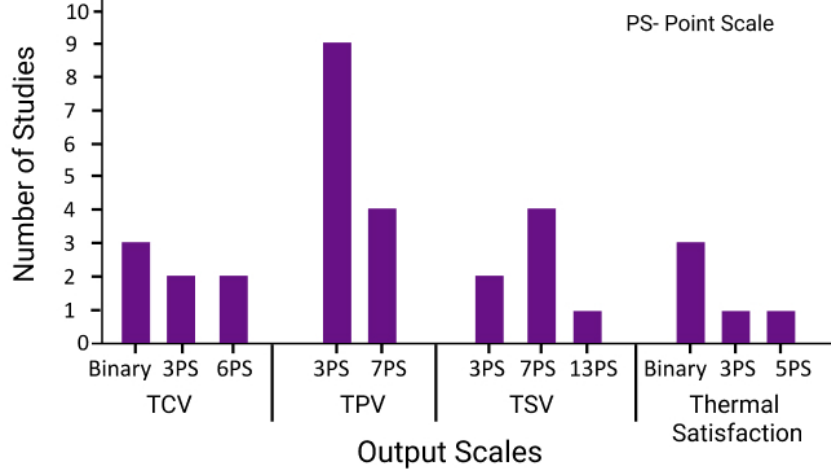
Figure 13. Reclassification strategies in MLTC works for